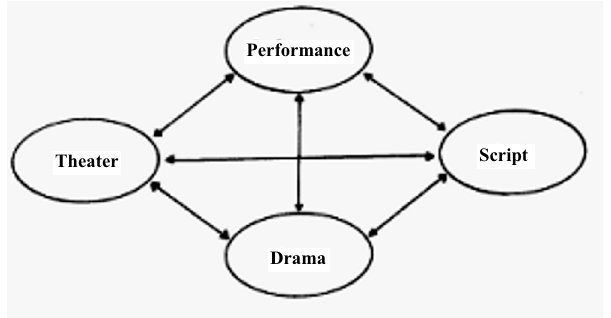
Fig. 2. Drama, script, theater, performance—second